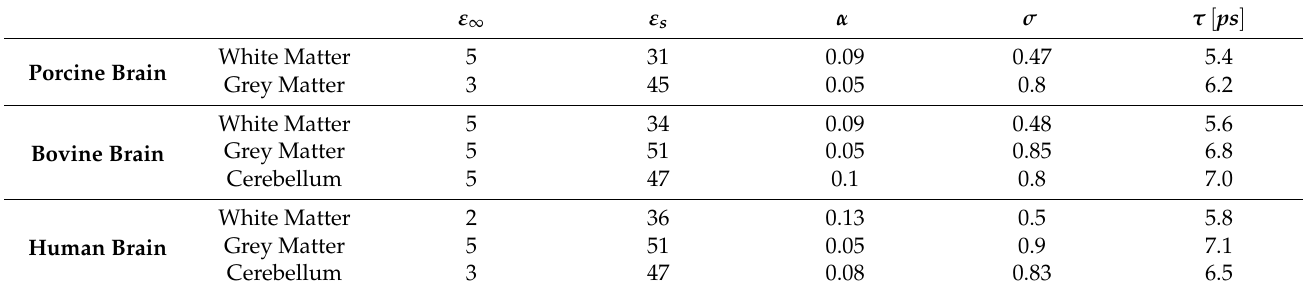
Table 3. Single pole Cole–Cole parameters for measured brain